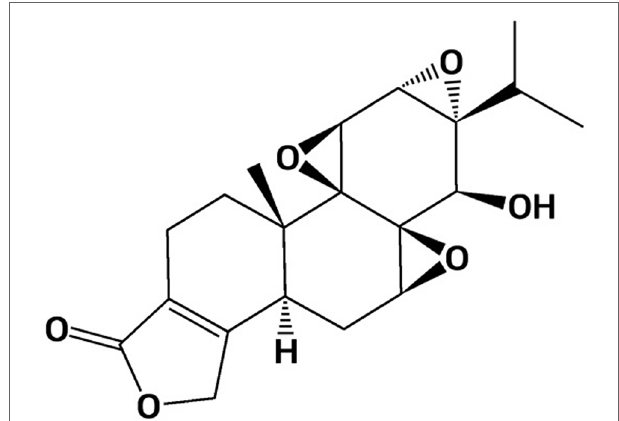
FIGURE 1 | Chemical structure of triptolide.Triptolide has been shown to possess a broad spectrum of anti-inflammatory and immunosuppressive properties in treating various inflammatory disorder models. Based on potent anti-inflammatory biological activities, triptolide has increasingly drawn attention worldwide in recent